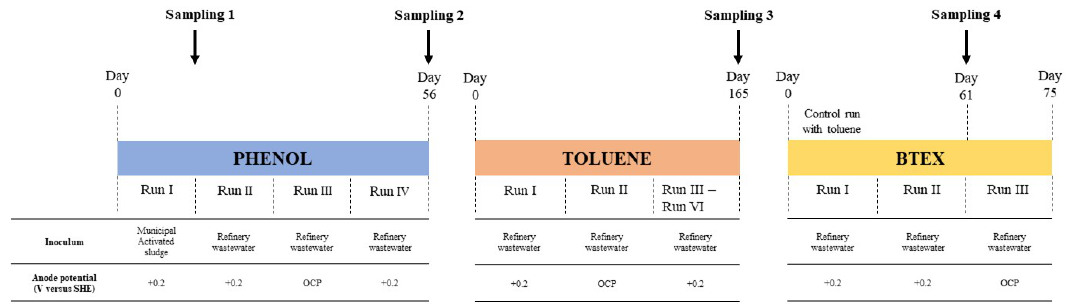
Figure 1. Experimental sampling procedure. Data were obtained from Palma et al., 2018 [16] (for phenol), Palma et al., 2018 [17] (for toluene) and Palma et al., 2019 [18] (for BTEX).